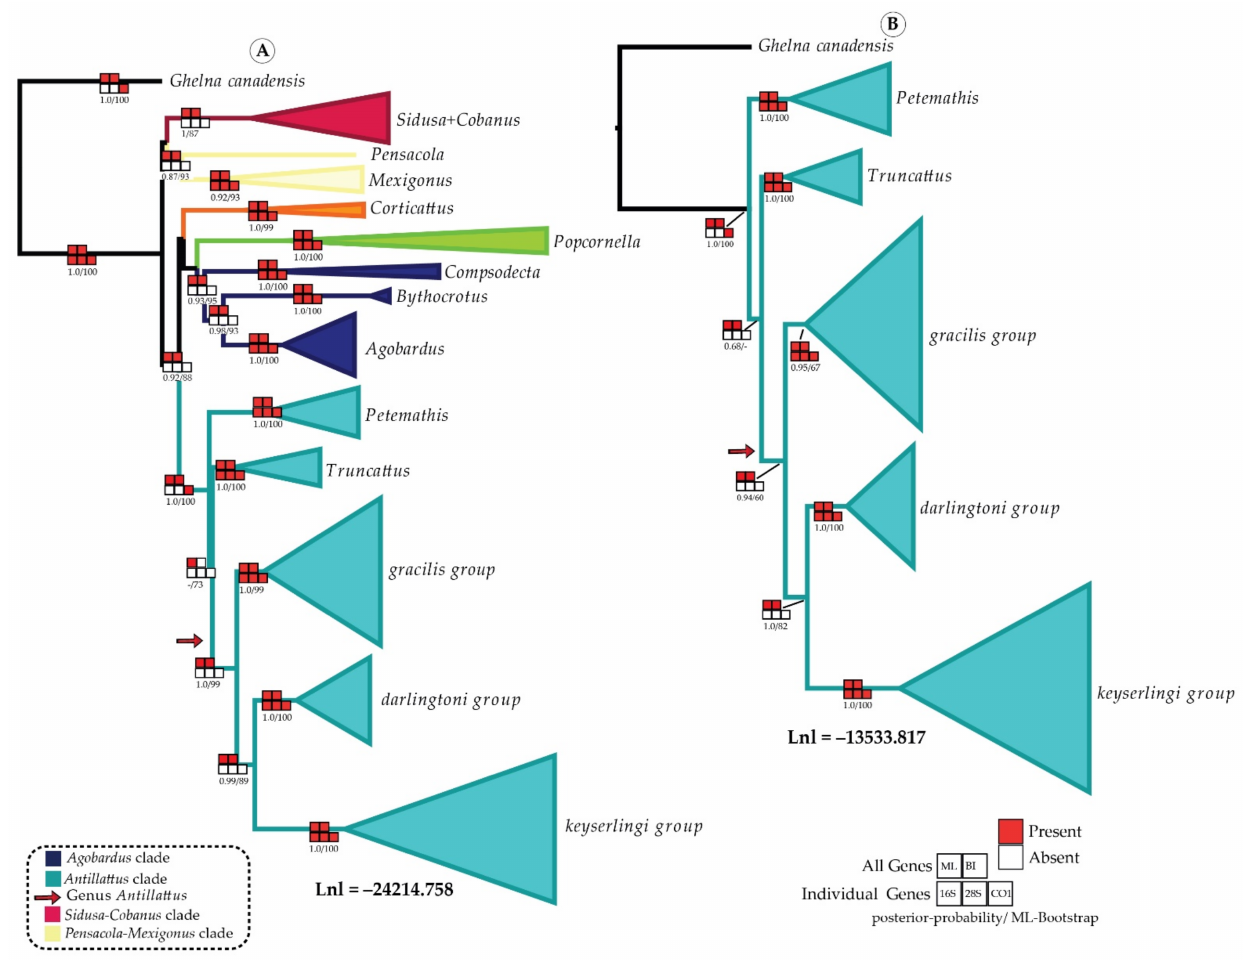
Figure 4. Summary of ( A ) ML (Lnl = − 24,214.785) and BI (Harmonic-means − 24,208.96) with outgroups and ( B ) ML (Lnl = − 13,533.817) and BI (Harmonic–means = − 13,597.32) without outgroups, based on analyses on the molecular datasets (28S, 16S-ND1 and CO1). Individual Gene refers to support for a clade in the ML tree of individual